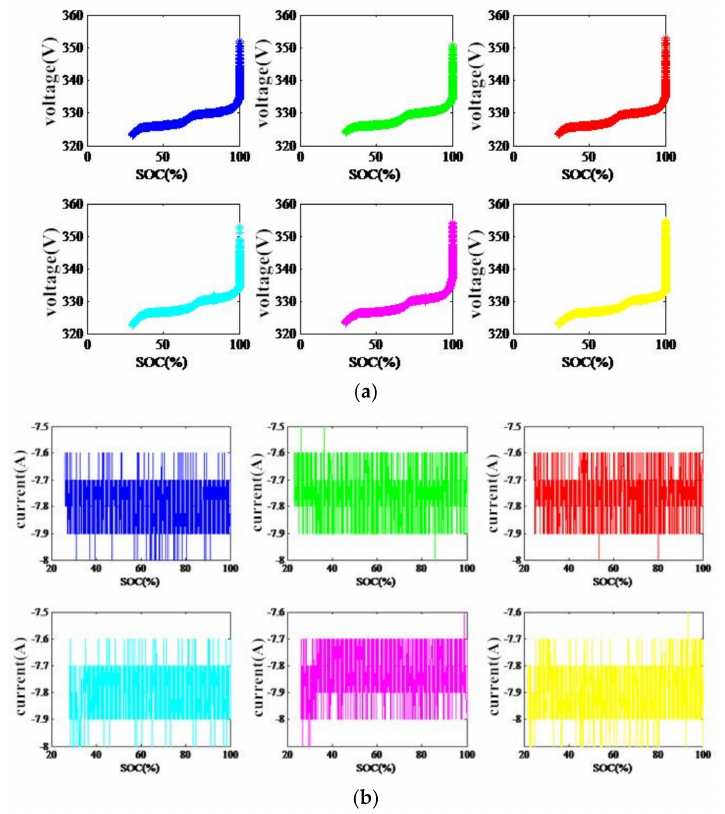
Figure 1. Charge voltage and current of six charging processes. ( a ) Charge voltage and SOC; ( b ) Charge current and